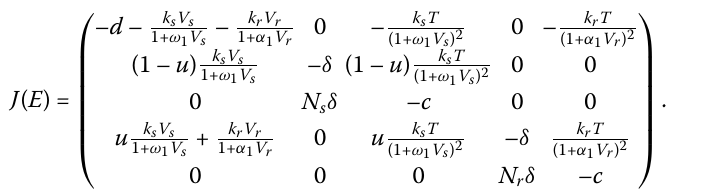
has no effect on Fig. 1. Along with the decreasing of saturated coefficient α 1 , the orange region will shrink, and it finally becomes the region { ( R s , R r ) : (1– u ) R s > R r > 1 } as α 1 → 0. On the contrary, along with the increasing of saturated coefficient α 1 , the orange region will enlarge, and it finally becomes the region { ( R s , R r ) : (1 – u ) R s > 1, R r > 1 } as α 1 → + ∞